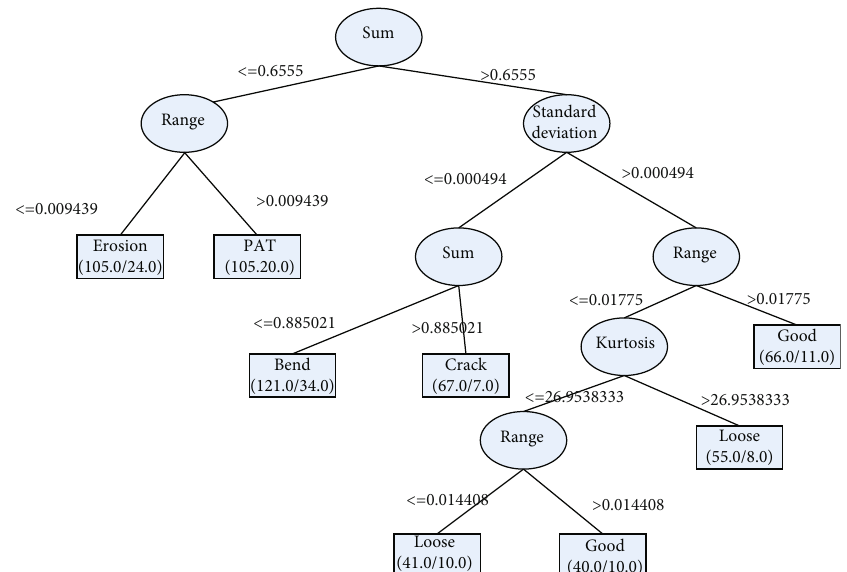
Figure 5: J48 Tree classi fi cation for feature Table 3: Features selected.